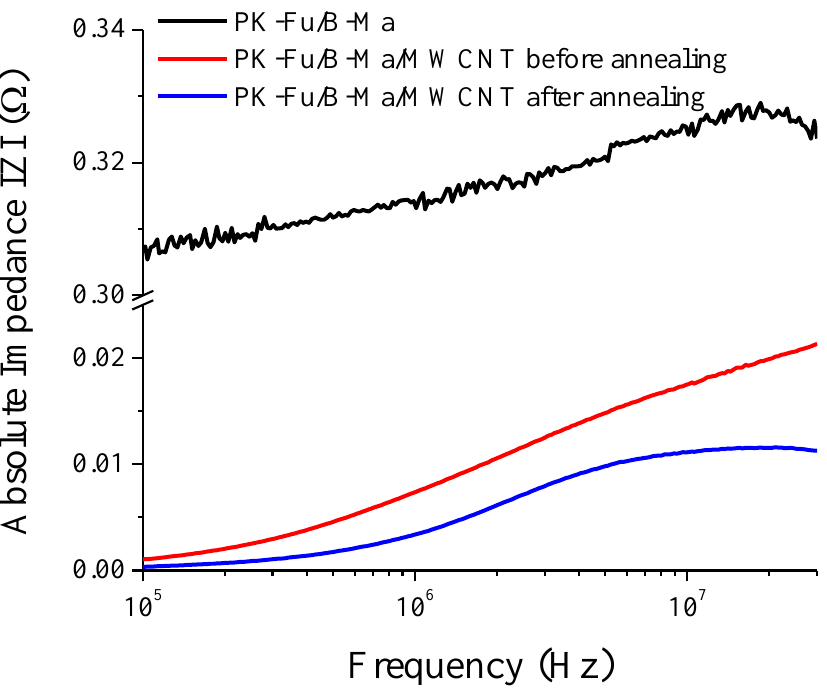
Figure 10. Variation of absolute impedance of PK-Fu crosslinked with B-Ma (PK-Fu/B-Ma) and of the crosslinked PK-Fu/B-Ma/MWCNT crosslink composite before and after resistive heating annealing using 35 V for 24 h.